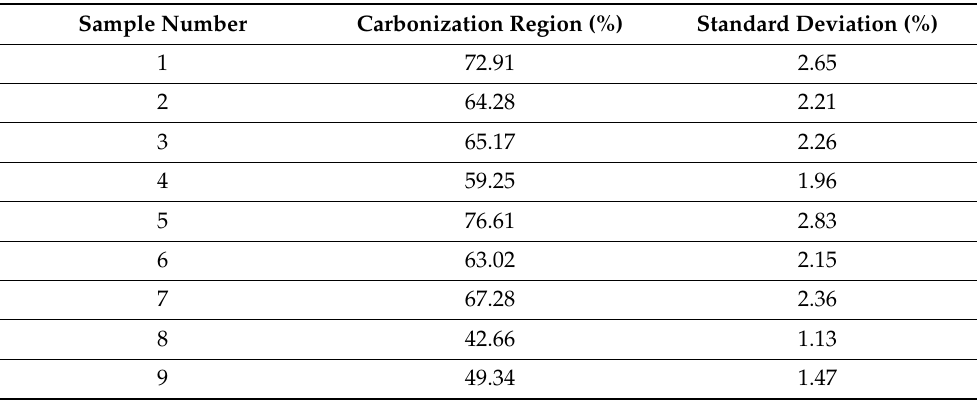
Table 5. Experimental outcome.